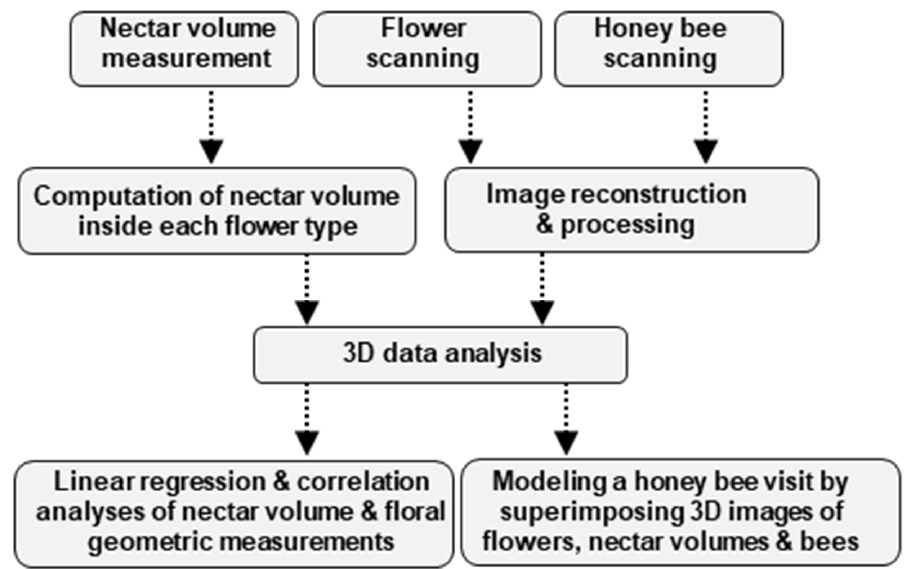
Figure 1. Mind map of the methodology used in this study. Three independent samplings were carried out, the sampling and measurement of nectar and scanning of the flower and the honey bee. Three‑dimensional volumetric data was obtained for the three samples which were used for geometric measurements of organs of interest. Finally, correlation analyses were performed between nectar volume and different nectary attributes. We modeled a honey bee visit by superim ‐ posing three data sets: the nectar volume, flower, and the honey bee.